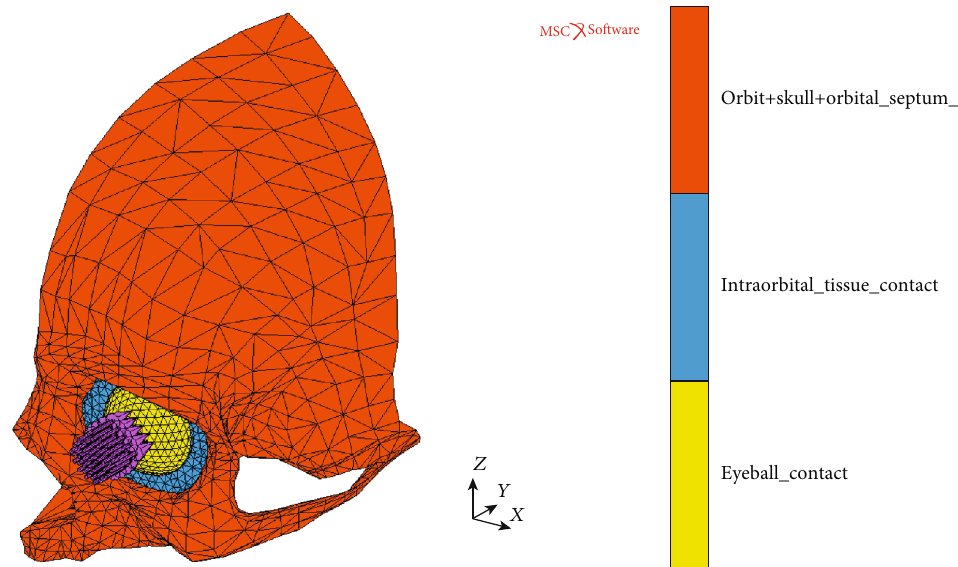
Figure 2: MOBOSE model (contact bodies) under the set of nodal